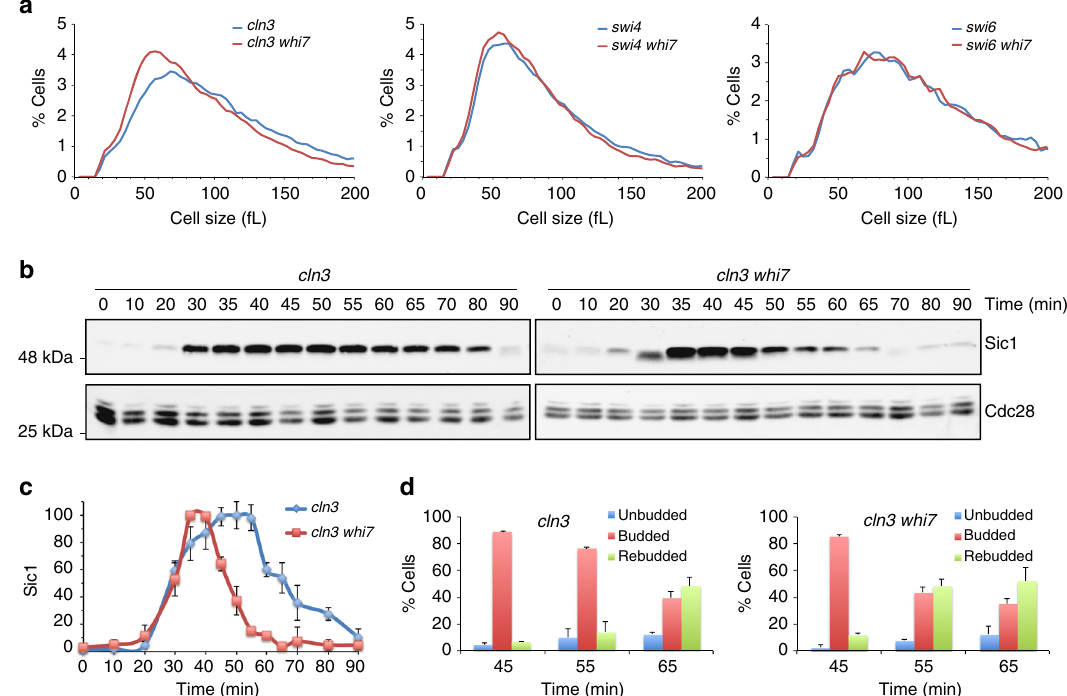
Fig. 4 Effect of whi7 mutation in Start timing in a cln3 mutant strain. a Cell size distribution in cultures of the cln3 (MT244), cln3 whi7 (JCY1868), swi4 (JCY167), swi4 whi7 (JCY1872), swi6 (JCY221), and swi6 whi7 (JCY1880) mutant strains. b Cultures of cdc15 cln3 SIC1-myc (JCY1837) and its derivative whi7 (JCY1896) mutant strain were arrested in telophase by incubation at 37 °C. After 3 h, cells were transferred to 25 °C and cell cycle progression was analyzed at the indicated time. Western blot shows Sic1 and Cdc28 (as loading control) protein level. c Plot represents the relative amount of Sic1 protein relative to Cdc28. d Budding as a marker of cell cycle initiation was monitored at the indicated times. Note that cdc15 mutant often shows a delay in cell separation after the release from the arrest, giving rise to the apparition of rebudded cells. Values in c and d are the mean and s.d. derived from three